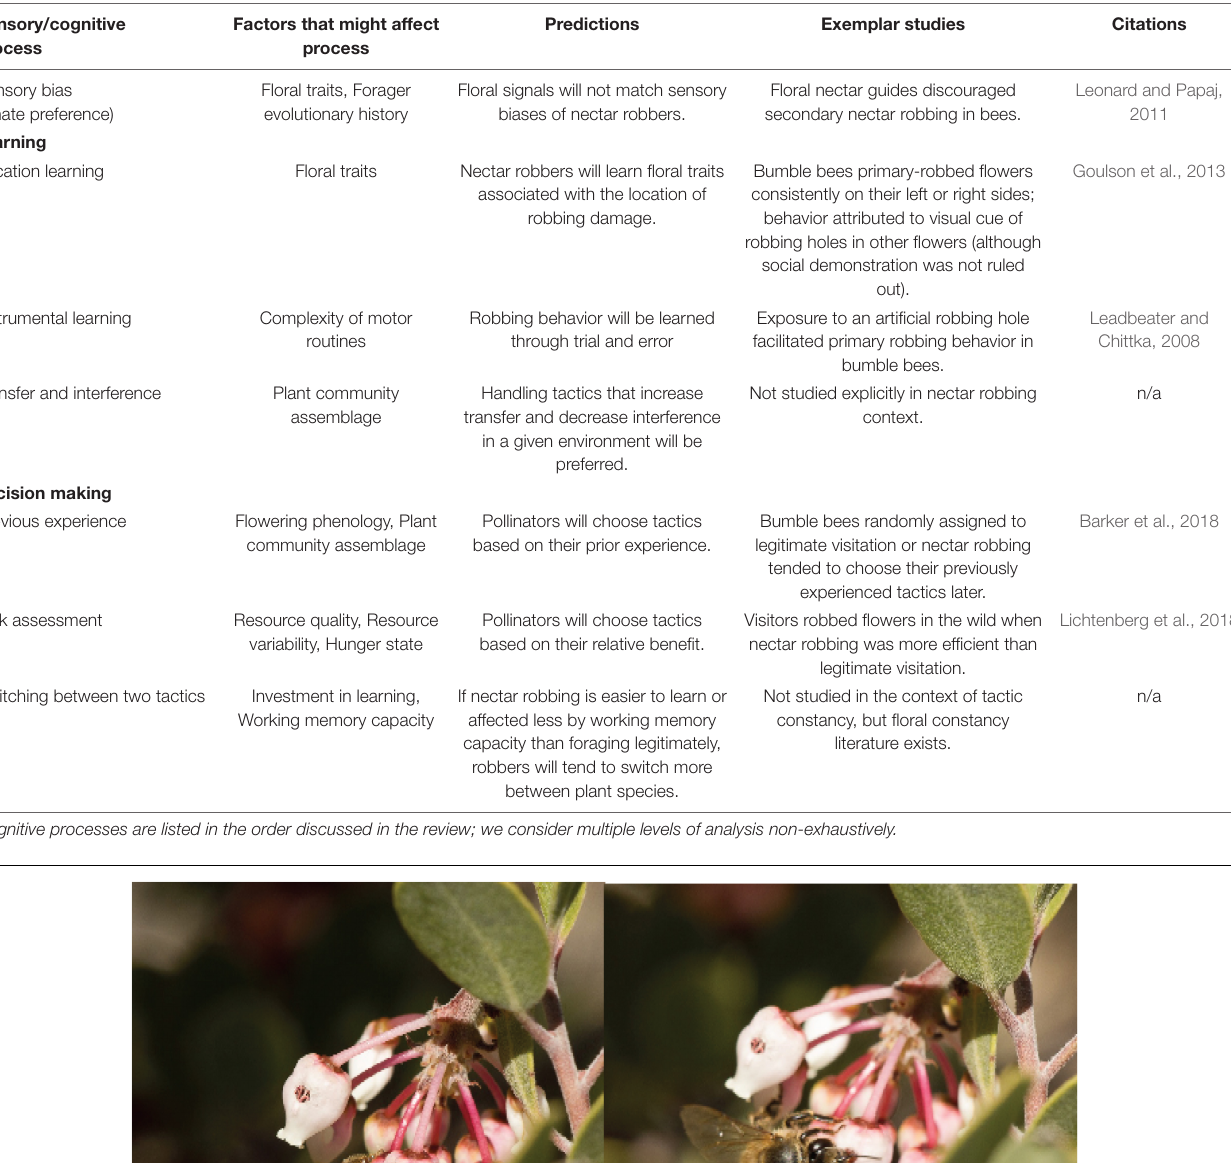
TABLE 1 | Sensory and cognitive processes involved in nectar robbing, including predictions, key findings and citations.